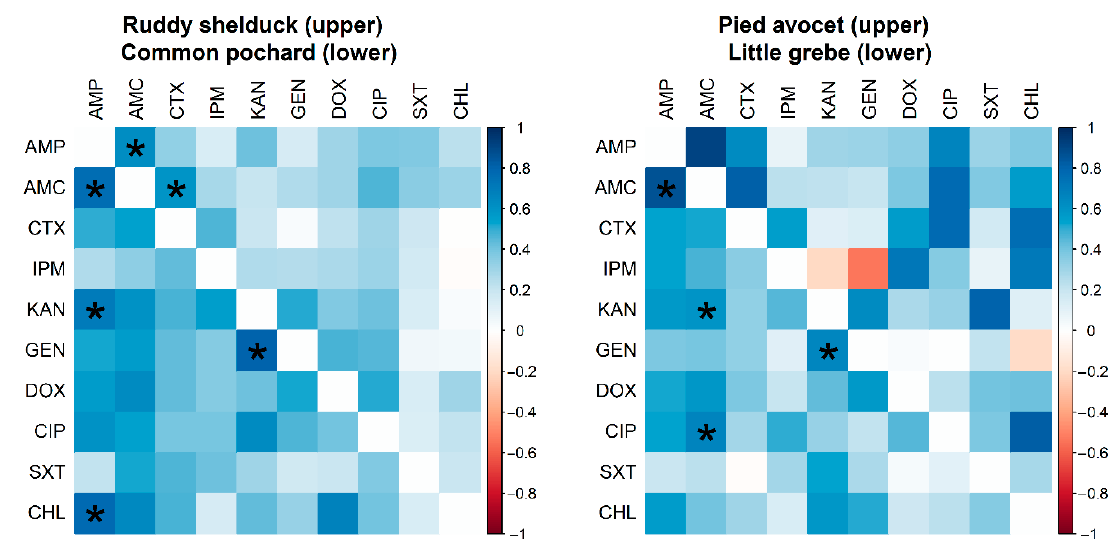
Figure 3. Spearman rank correlation test results based on the minimum inhibitory concentrations of Escherichia coli ( n = 90) isolates recovered from different species of migratory wild birds for ten antimicrobials. The blue color indicated a positive correlation, and the red shows a negative correlation. Strikes ( * ) indicate significance at p < 0.001.